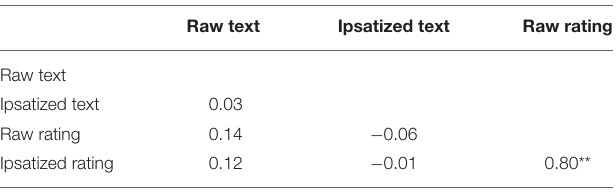
TABLE 8 | Overall similarity of the correlation matrices (using Mantel correlations) in Study